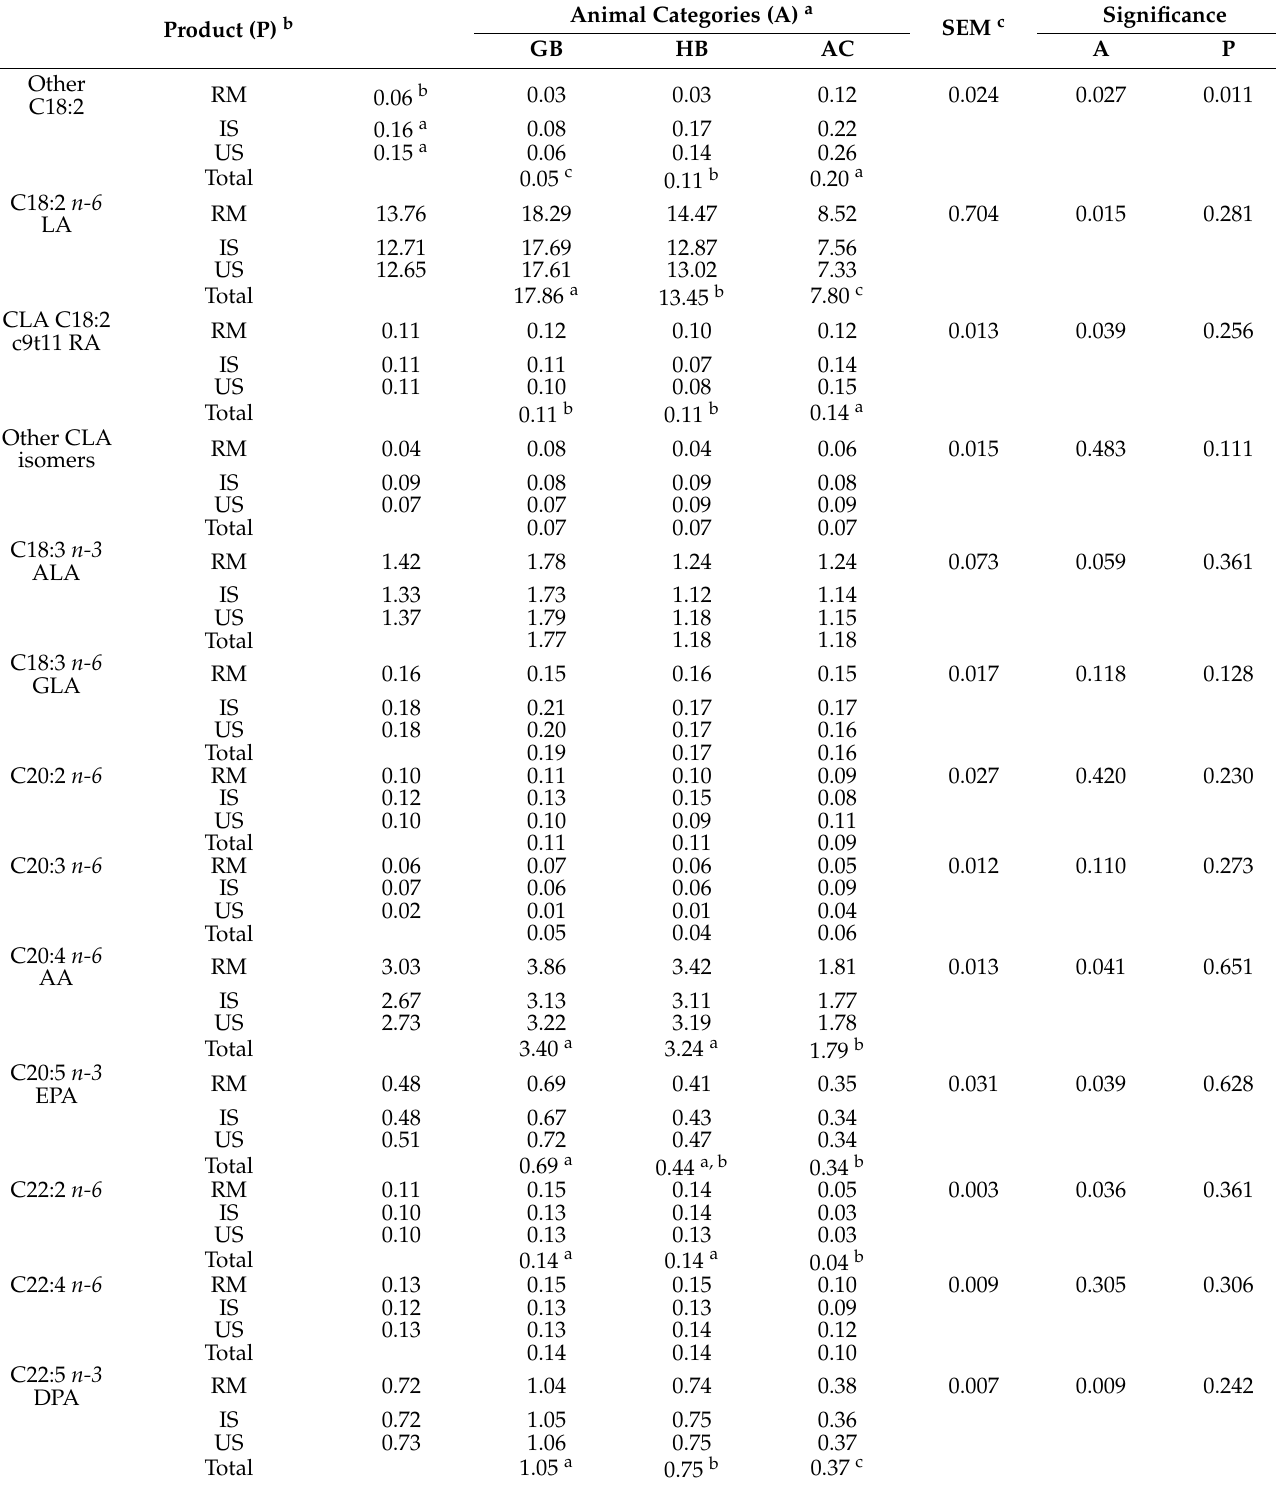
Table 5. Effects of animal category and product on polyunsaturated fatty acids (% of total FA) of salami